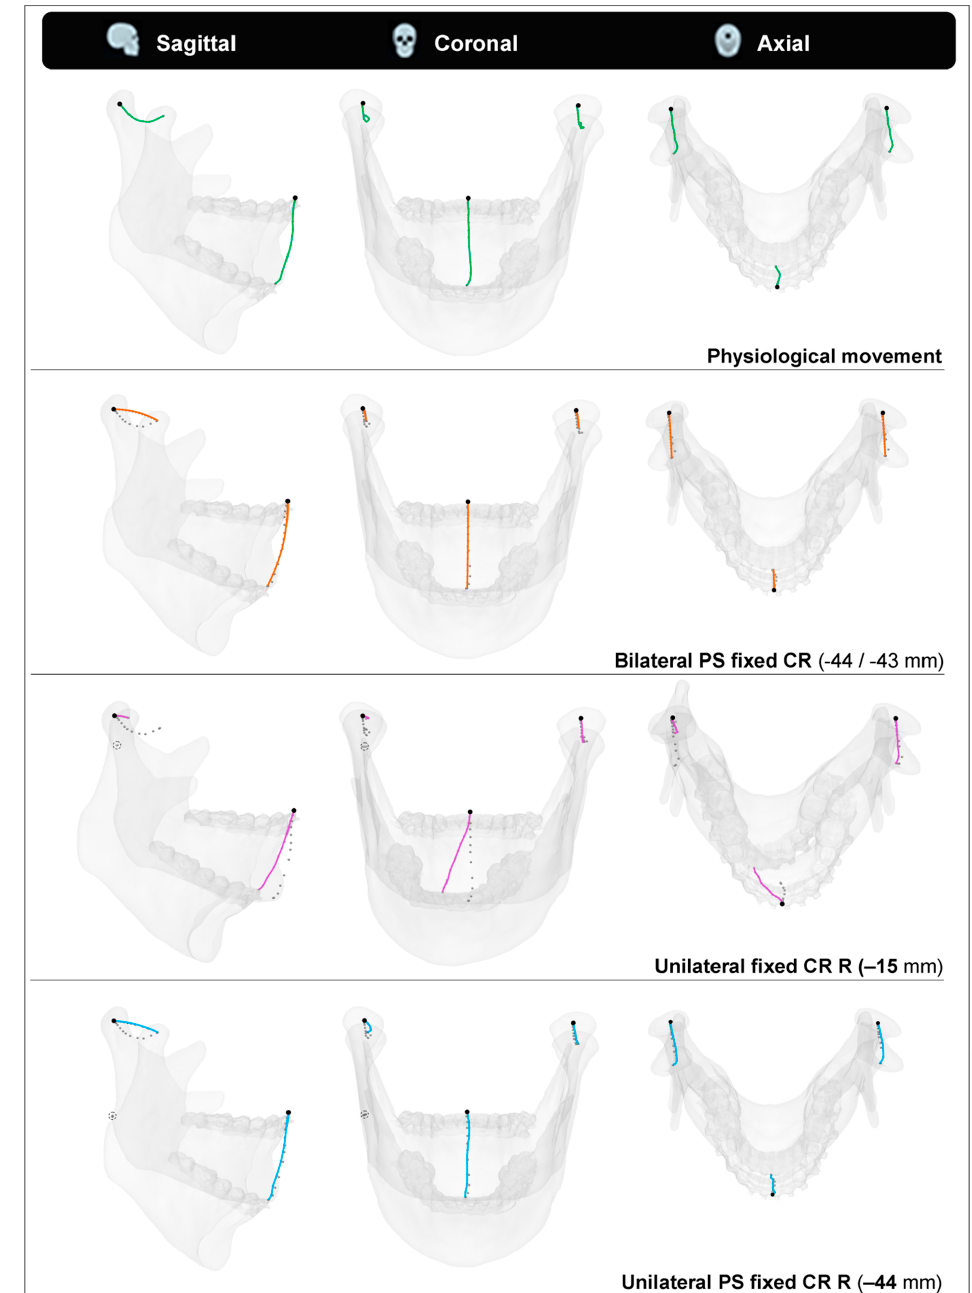
Figure 6. Condylar and incisal point traces describing the mouth opening movement in four different scenarios. Top to bottom: Physiological movement describes the actual recorded movement pattern for this specific subject. Bilateral PS fixed CR describes a simulated mouth opening around the patient-specific (PS) axis of rotation determined with our workflow. Unilateral fixed CR R describes a simulated mouth opening with a fixed centre of rotation (CR) at 15 mm inferior to the centre of condyle (CoC) and the physiological movement of the left condyle. Unilateral PS fixed CR R describes a simulated mouth opening with a fixed CR at the PS determined position, 44 mm inferior to the CoC and the physiological movement of the left condyle. The dotted traces in the three simulated mouth openings indicate the physiological movement traces. Note the severe lateral deviation that occurs when the CR is positioned much closer to the CoC than PS